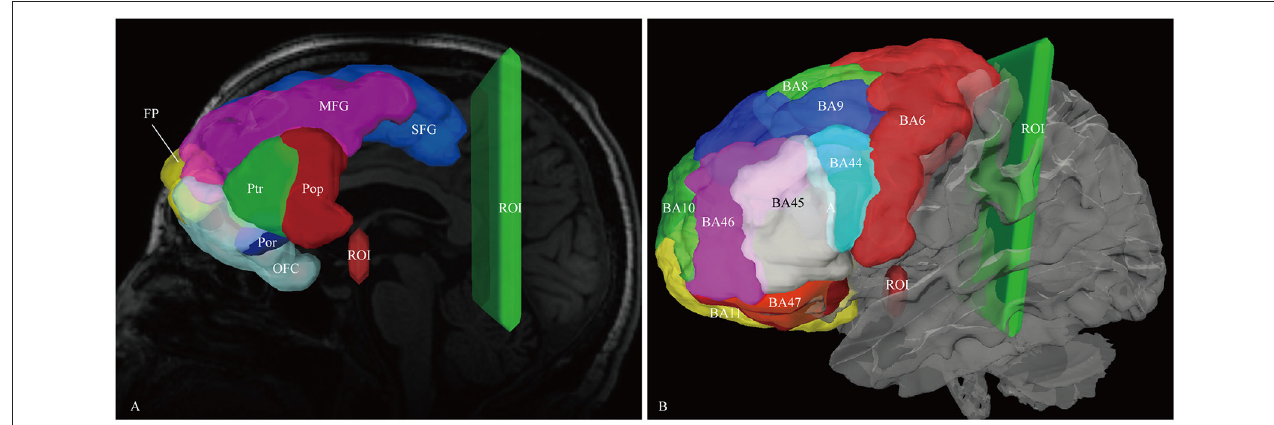
FIGURE 1 | In vivo fiber tractography of the IFOF. (A) Frontal lobe labels were used as the seeding regions for the reconstruction of the IFOF, including the superior frontal gyrus (SFG, blue), middle frontal gyrus (MFG, pink), inferior frontal gyrus [i.e., pars opercularis (Pop, red), pars triangularis (Ptr, green), and pars orbitalis (Por, blue)], frontal polar (FP, yellow) and orbito-frontal cortex (OFC, cyan). Two ROI masks were drawn to select only the fibers that passed from the frontal lobe to the posterior region. One was around the ventral part of the external capsule on the coronal quantitative anisotropy color map, the other was on the coronal plane at the level of the central sulcus. (B) Brodmann areas (BA) overlaid on the white matter surface. ROI, region of interest.